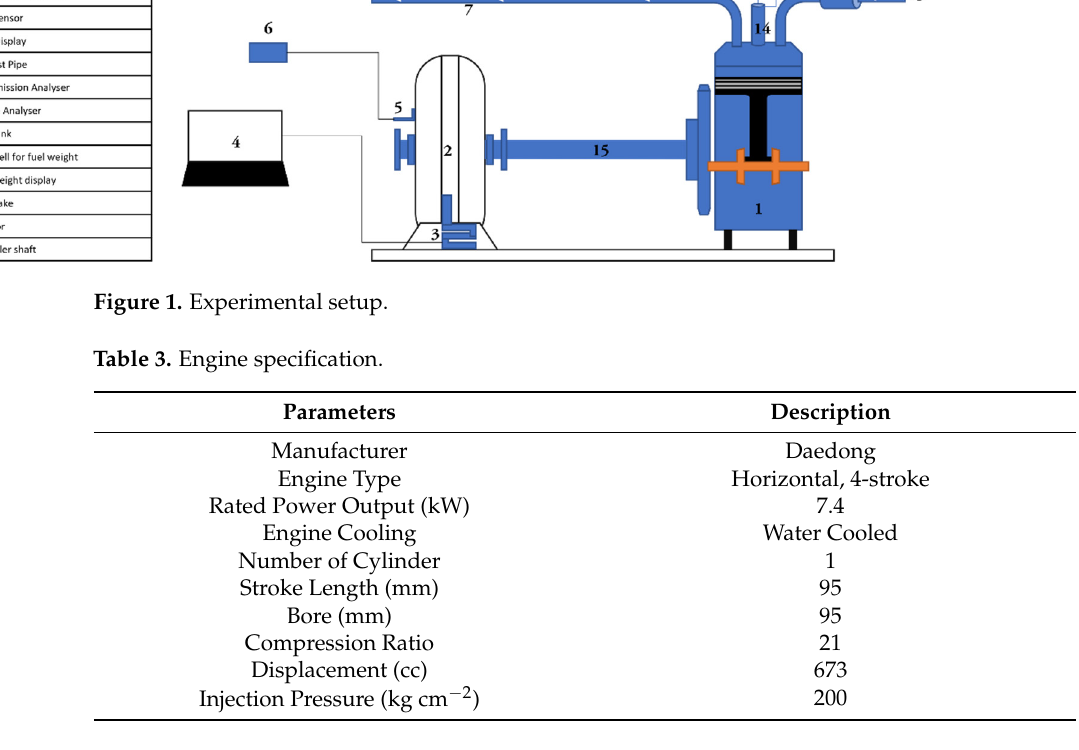
Table 4. Range and resolution of the smoke meter and gas